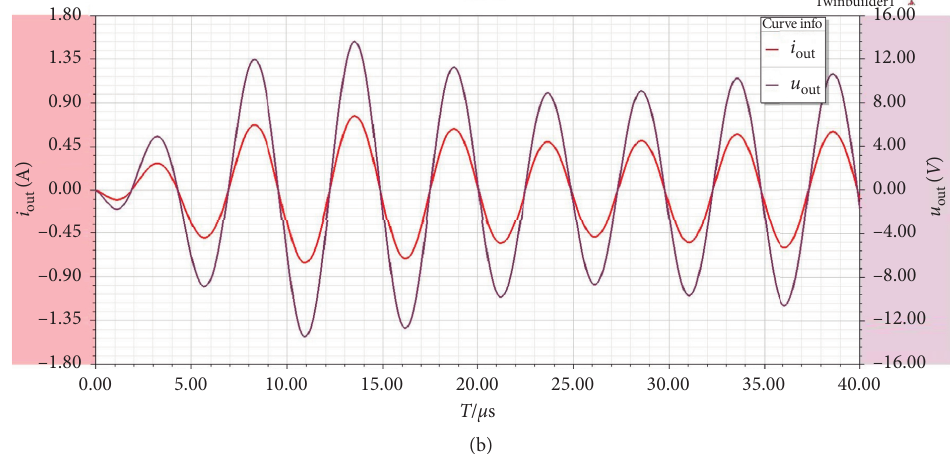
Figure 8: Waveform of simulation voltage and current. (a) Input voltage and current waveform. (b) Output voltage and current waveform.